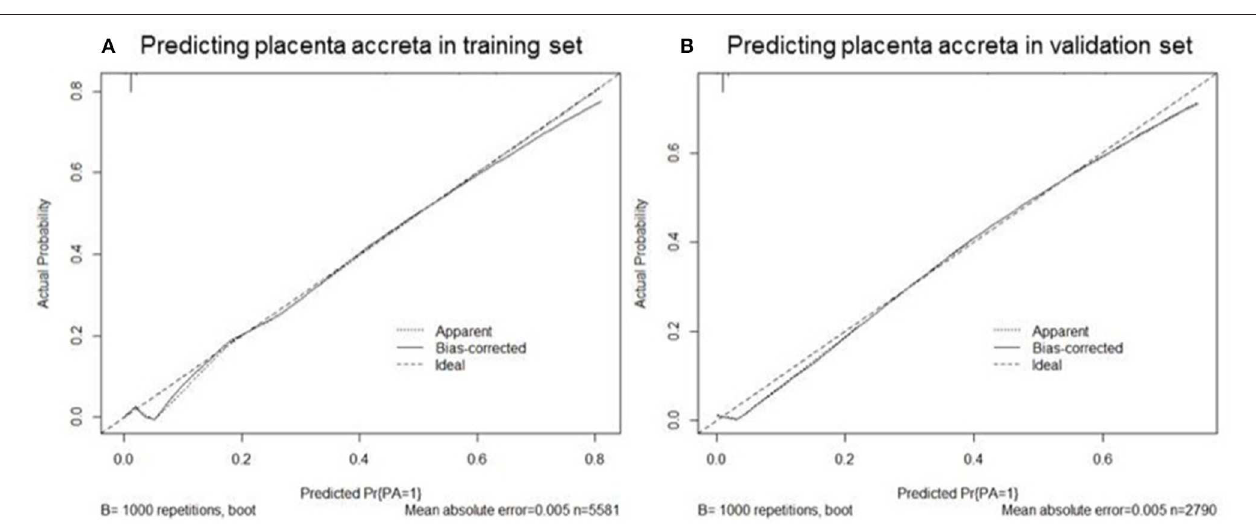
FIGURE 2 | Calibration plots of nomogram to predict the probability of placenta accreta in the training set (A) and validation set (B) . The x-axis is the predicted placenta accreta calculated by the nomogram, and the y-axis is the observed placenta accreta. The “Ideal” is the ideal curve, and the solid line “Bias-corrected” is the actual